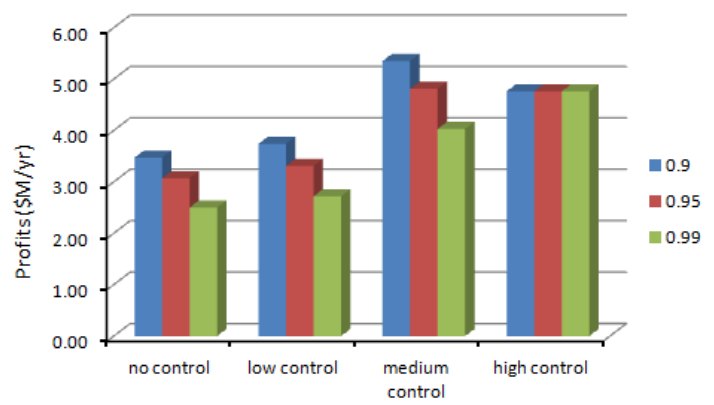
Figure 7. The annual net profits results from CCNLP method.